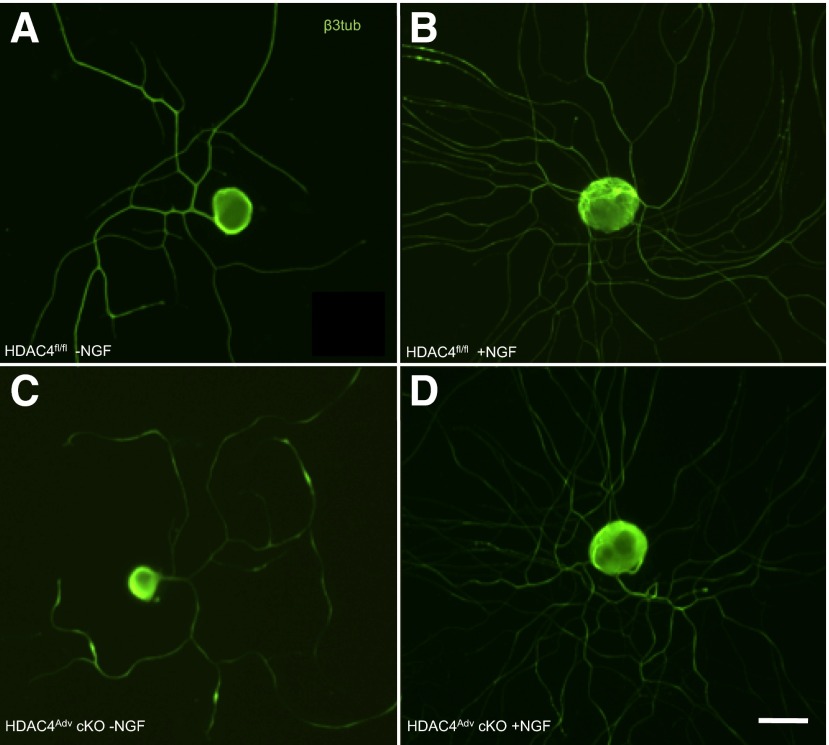
HDAC4 wild-type (A, B) and cKO (C, D) neurons were grown in the absence (A, C) or presence (B, D) of 100 ng/ml NGF for 24 h, then immunostained for β-III-tubulin. Scale bar, 20 μm.